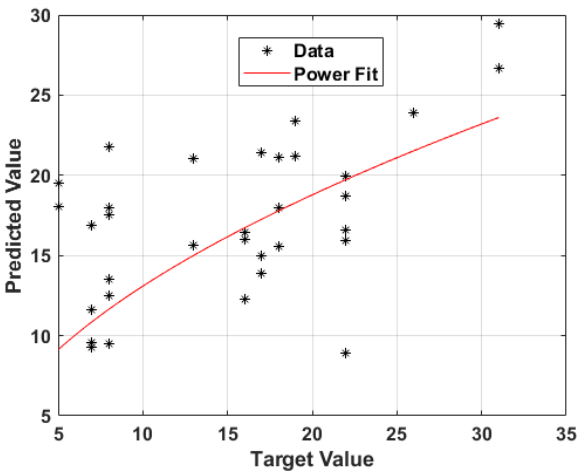
Figure 13. System failure plot of target vs. predicted value for MLR Model 2